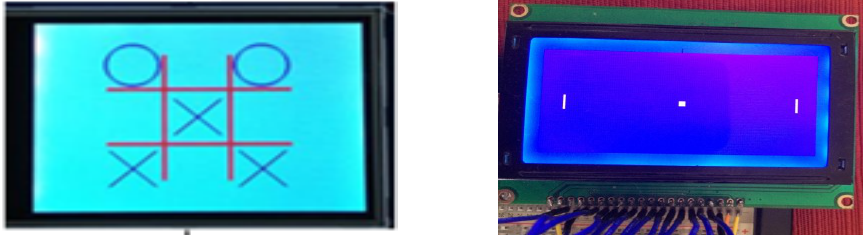
Fig. 4. A Tic-Tac-Toe game touch screen interface and a simple ping-pong game.